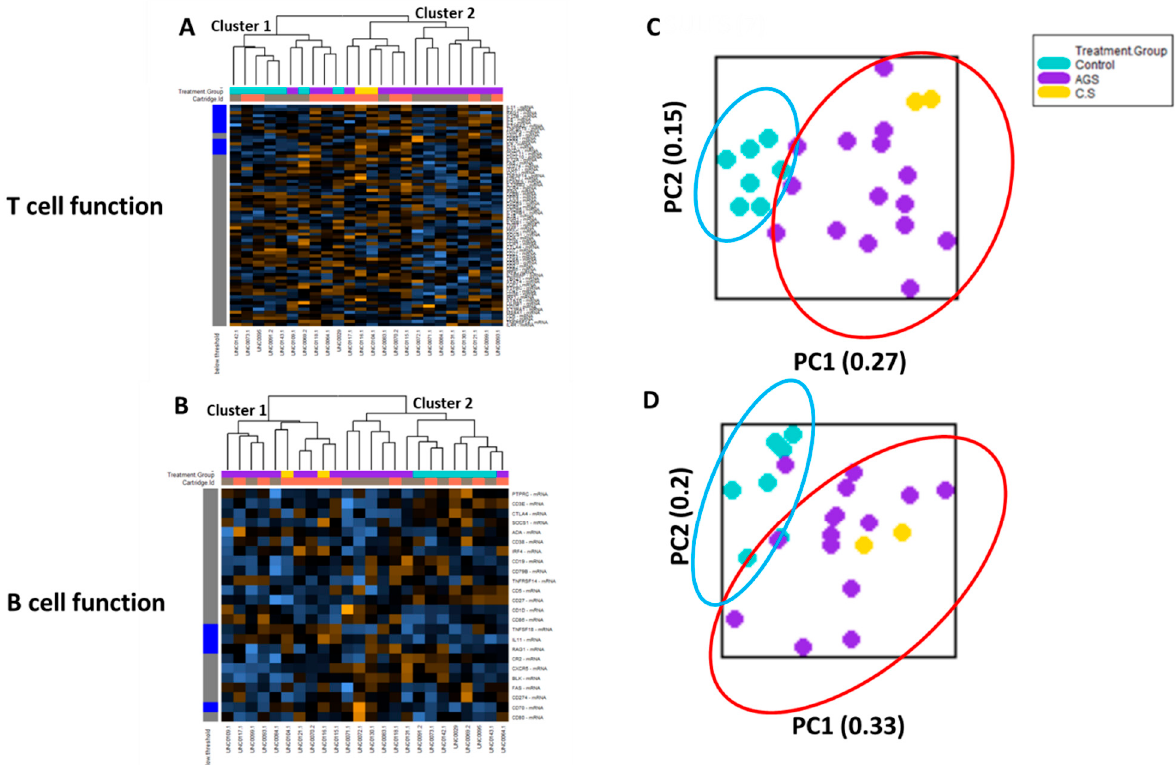
Figure 4. Transcriptional immune profiles for B and T cell function from control and alpha-gal-sensitized subjects are largely distinct. Heatmap of the normalized gene expression data and unsupervised hierarchical clustering of genes associated with ( A ) T cell function and ( B ) B cell function. ( C ) Principal component analysis of gene expression data associated with T cell function and ( D ) B cell function. Control ( n = 7); sensitized (“CS” n = 2); alpha-gal syndrome (“AGS” n = 15).